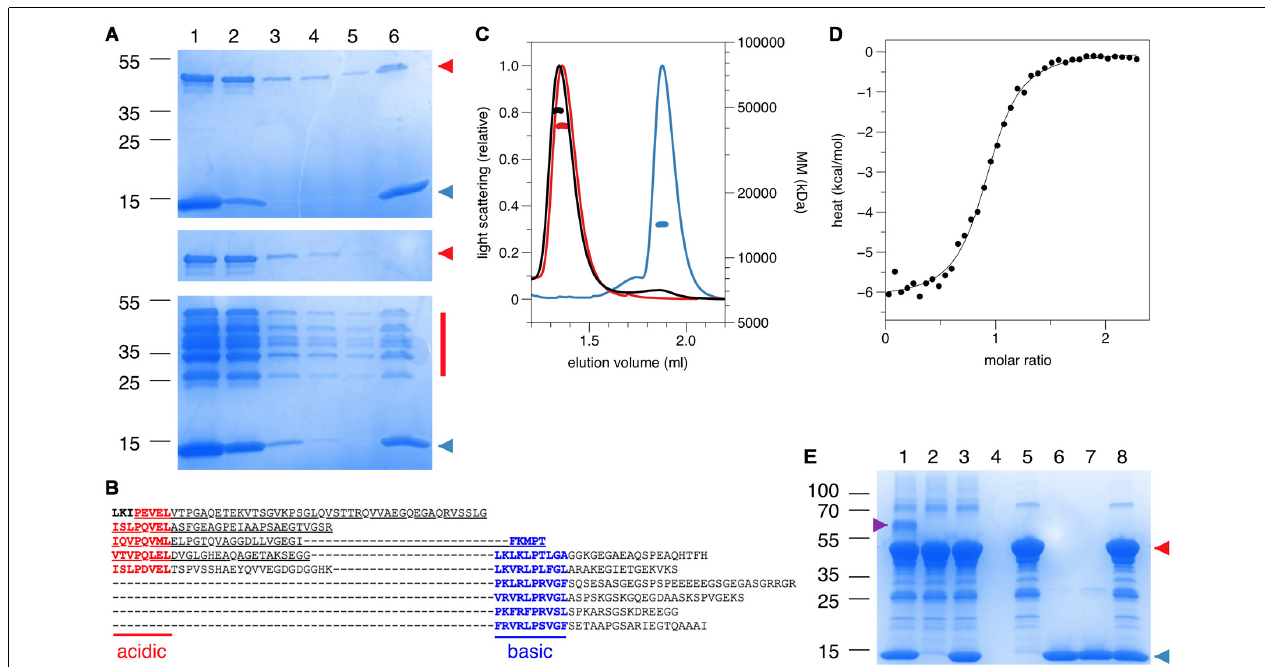
FIGURE 2 | Direct molecular interaction assays using purified recombinant proteins. (A) Pulldown with pure recombinant proteins on a Ni-NTA affinity matrix. Top, PRX-C and His-tagged β 4-FNIII-3; middle, PRX-C alone; bottom; partially degraded PRX-C and His-tagged β 4-FNIII-3. Samples: 1, input sample; 2, unbound fraction; 3–5, washes; 6, elution. PRX-C is indicated in red and β 4-FNIII-3 in blue. Sizes of molecular weight markers are indicated on the left (kDa). (B) Sequence of the PRX-C construct, indicating the presence of acidic and basic repeats. The underlined segment (the acidic domain) can be detected in all the PRX-C bands in the bottom panel of (A) . (C) Size exclusion chromatography (SEC)-MALS analysis shows molecular mass expected for a 1:1 complex. PRX-C, red; β 4-FNIII-3, blue; complex, black. (D) Isothermal titration calorimetry (ITC) titration of the complex indicates 1:1 stoichimetry. ∆ H = 6.2 ± 0.06 kcal/mol, ∆ S = 5.8 cal/mol ◦ . (E) Covalent crosslinking. The complex is only visible when both proteins have been activated (Lane 1). The magenta arrowhead indicates the 1:1 complex. PRX-C is indicated in red and β 4-FNIII-3 in blue. Samples: 1, both proteins activated; 2, PRX-C activated; 3, PRX-C activated, β 4-FNIII-3 added; 4, no activation; 5, no activation, PRX-C added; 6, no activation, β 4-FNIII-3 added; 7, β 4-FNIII-3 activated; 8, β 4-FNIII-3 activated, PRX-C